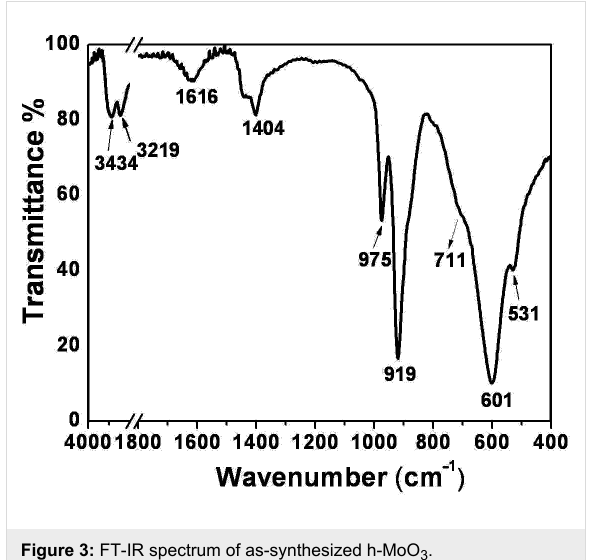
Figure 3: FT-IR spectrum of as-synthesized h-MoO 3 .